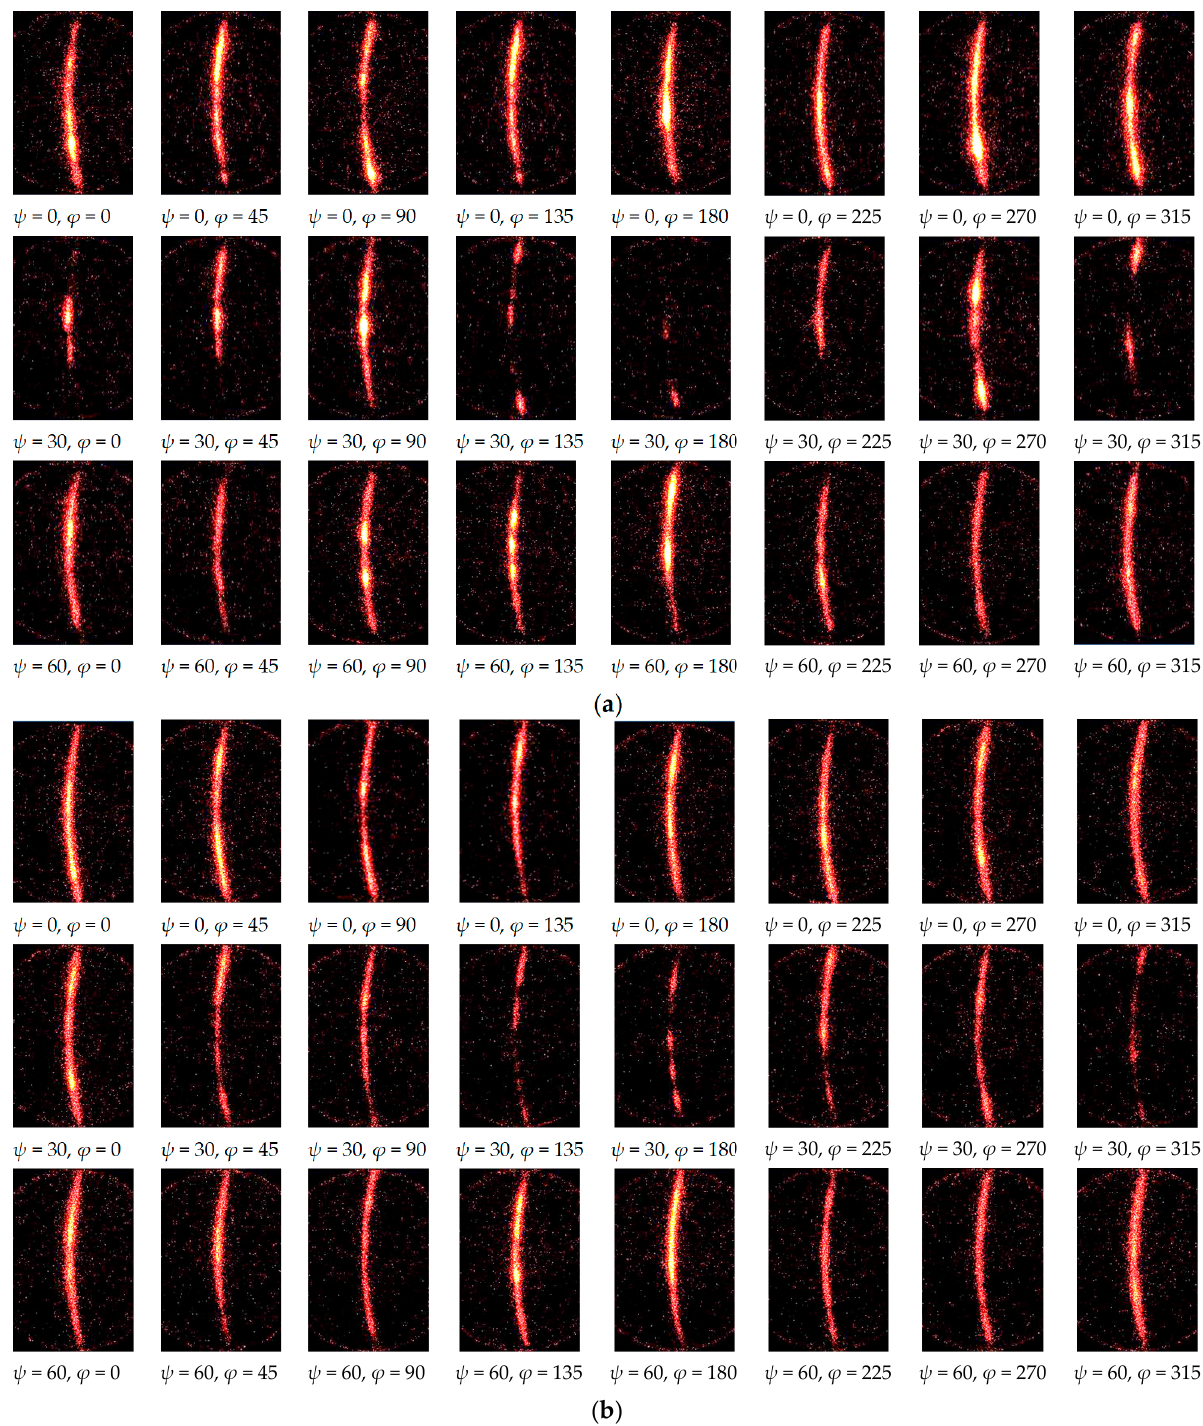
Figure 9. X-ray diffraction patterns detected by 2D-PSPC from the stainless steel treated by cavitation peening (Specimen A). ( a ) ∆ ω = 0°; ( b ) ∆ ω = 10°.